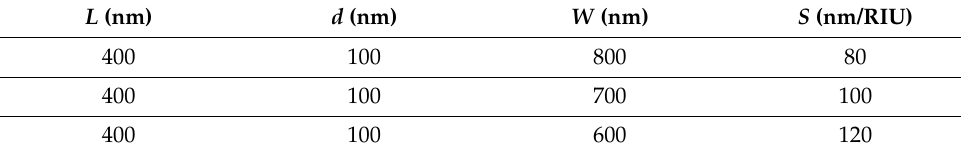
Figure 16. Spectral characteristics of SWG waveguide-FP structure, ( a ) FP peak versus ARI, ( b ) Sensitivity. Table 6. Sensing performance of the SWG waveguide-FP structure versus W